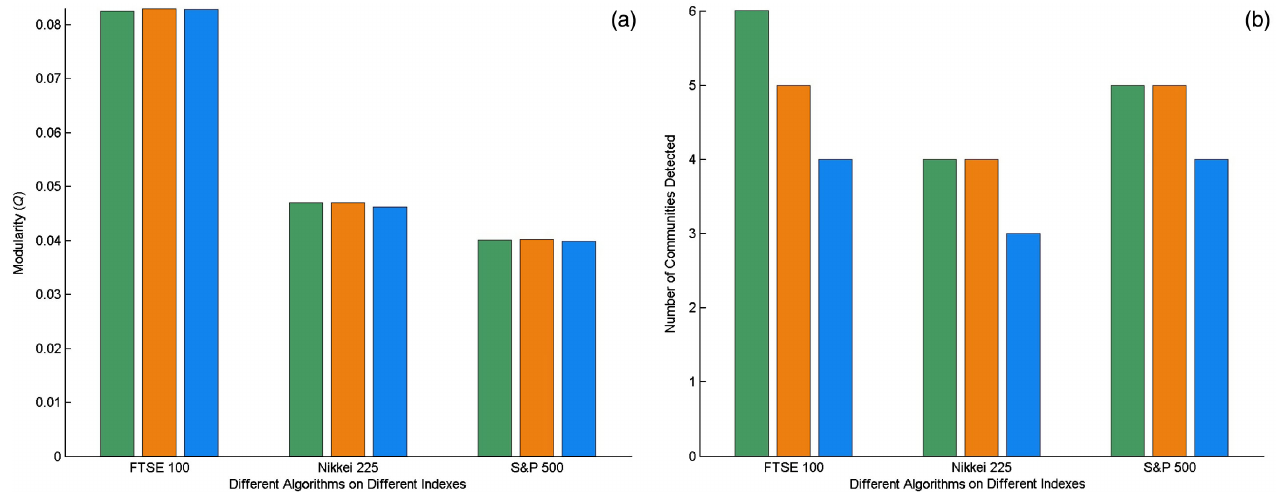
FIG. 10. Maximized modularity values Q 3 ð ~ σ (cid:4) Þ (a) and number of detected communities (b) for each of the three markets (log-returns of daily closing prices from 2001Q4 to 2011Q3). The green bar is the Potts algorithm, the orange bar is the Louvain algorithm, and the blue bar is the spectral algorithm.